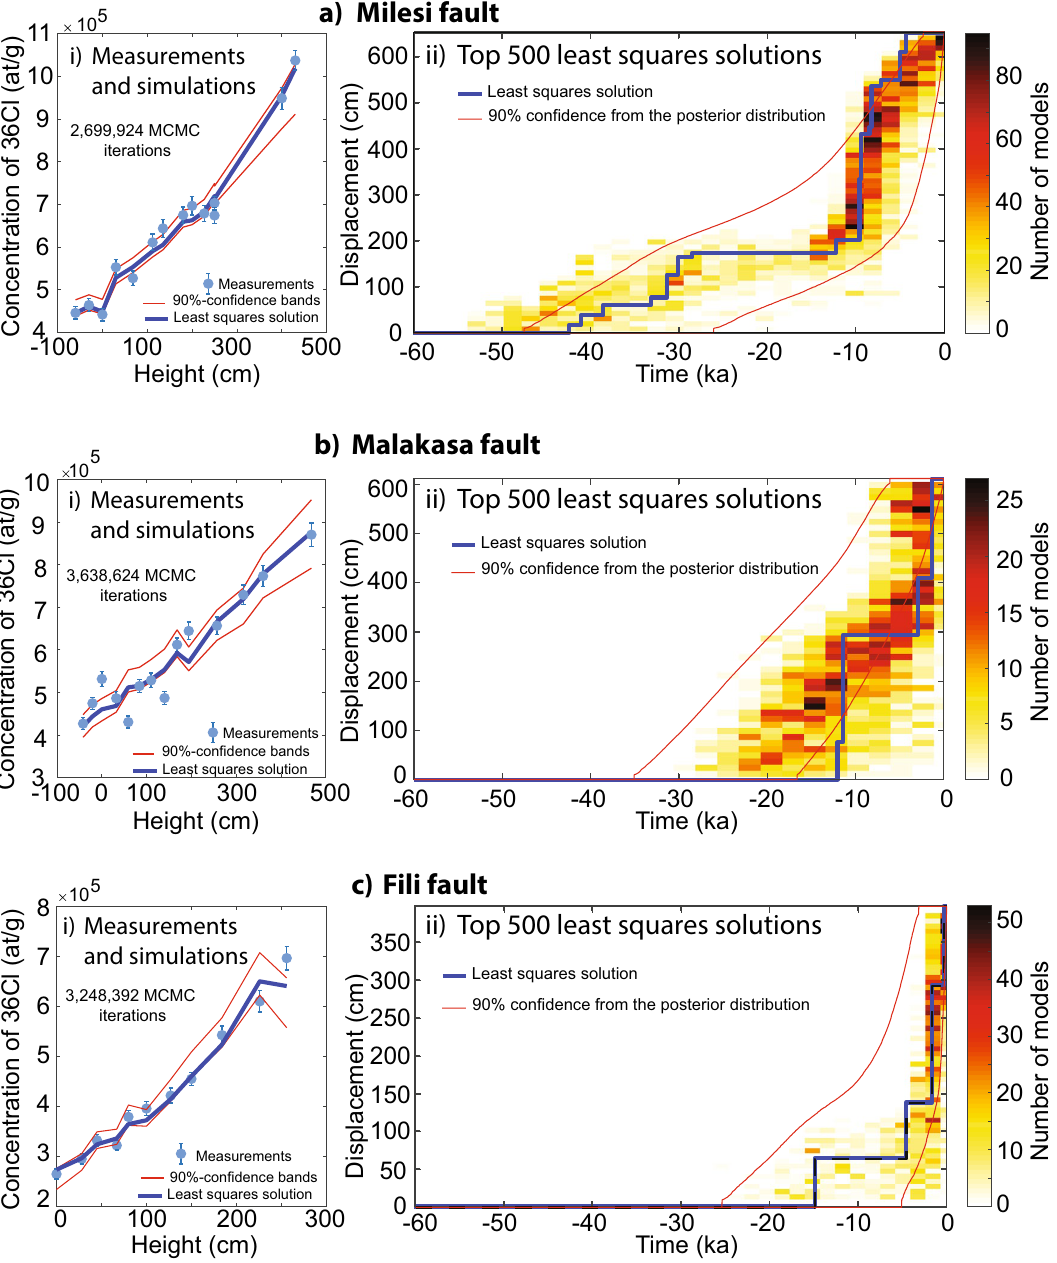
Figure 2. Inference of slip histories from 36 Cl concentrations measured on the Milesi, Malakasa, and Fili faults ( a – c ). ( a.i – c.i ) show the measurements and Bayesian posterior distributions of the concentrations of 36 Cl. ( a. ii – c.ii ) show the best 500 least squares solutions for slip histories for the 3 faults. Blue lines are the least squares solutions. Red lines show the 90% confidence interval from the posterior distribution. Full Bayesian solutions are shown in Supplement